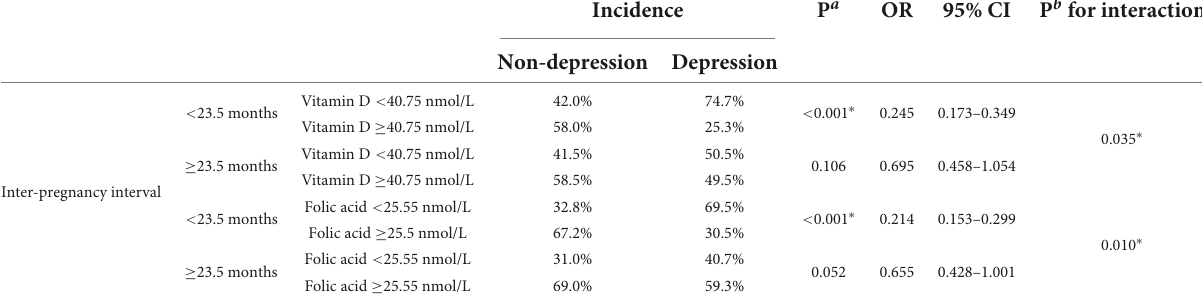
TABLE 4 Interaction effects between IPIs and trace elements on the risk of depression during pregnancy. Incidence P a OR 95% CI P b for interaction